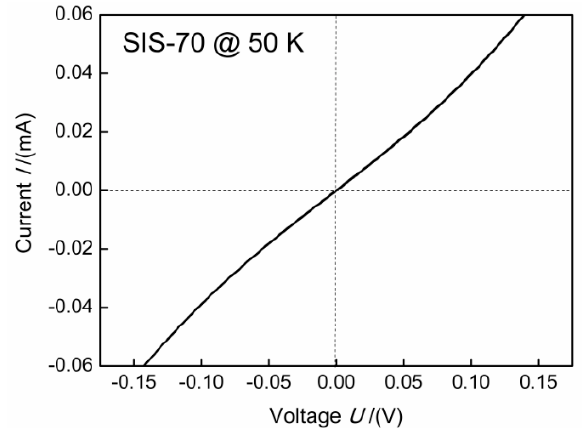
Figure 6. I–V curves of the YBCO/LAO (70 nm)/YBCO trilayer film.